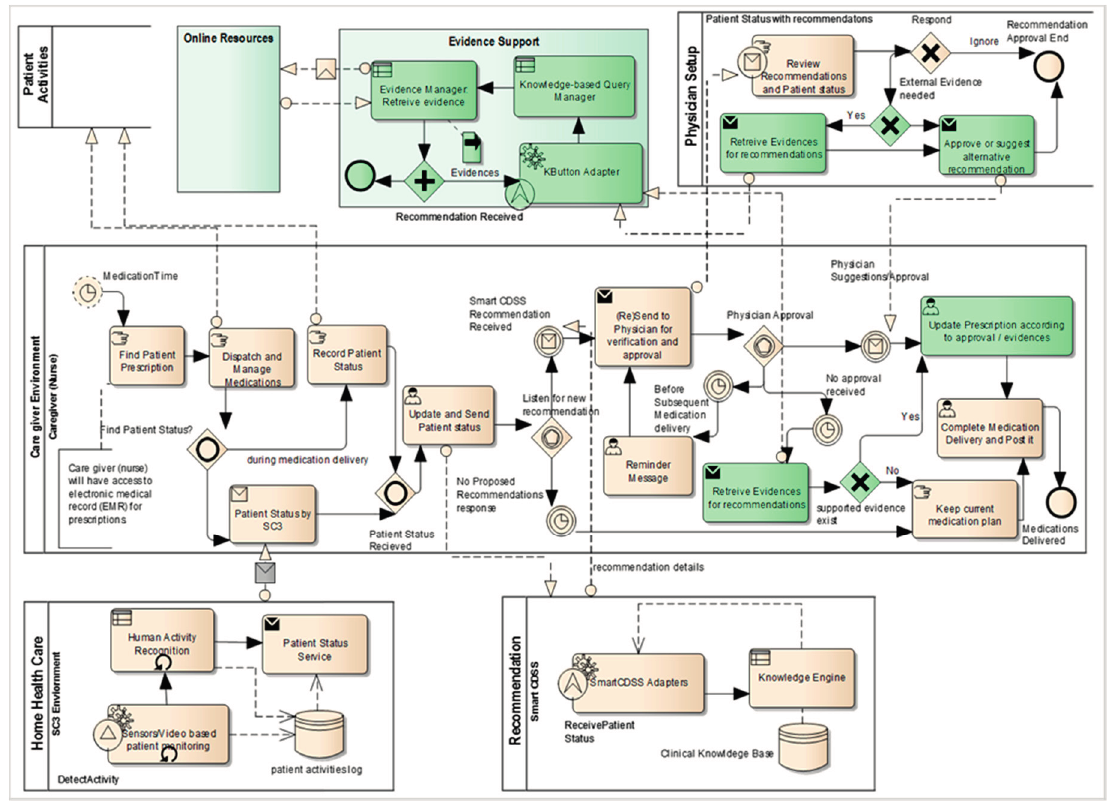
Figure 10. Evidence-supported medication recommendation service workflow represented in Business Process Model and Notation process model where the set of activities is represented as a pool using Enterprise